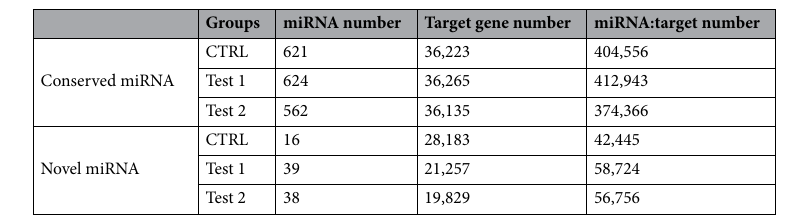
Table 3. Numbers of mirRNA targets in the three libraries of Control (CTRL), Test 1 and Test